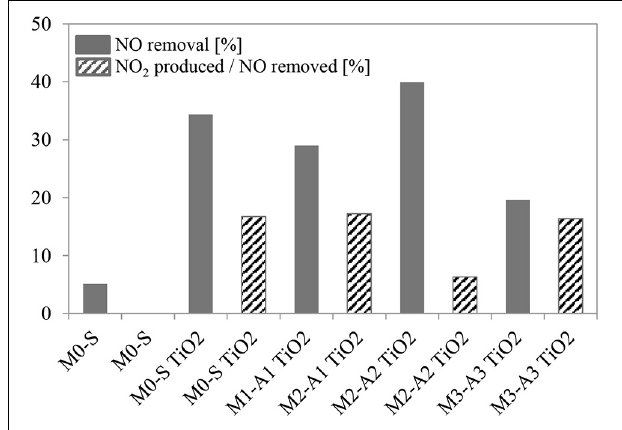
FIGURE 6 | Photocatalytic efficiency of mortars under UV-A radiation.